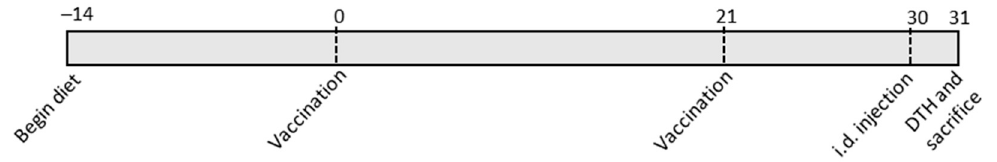
Figure 1. A schematic overview of the murine model of vaccination.